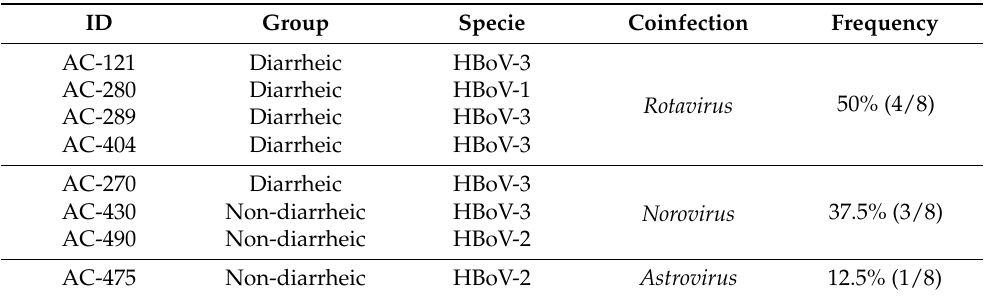
Table 3. Coinfection involving HBoV and other enteric viruses in children from Acre State, Brazil 2012. ID Group Specie Coinfection